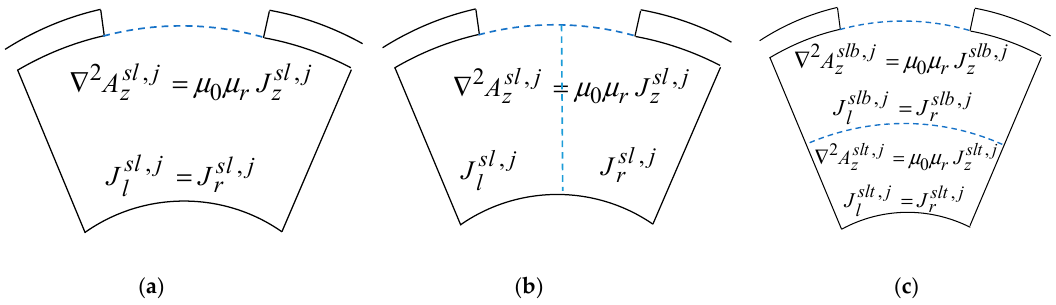
Figure 3. Sub-region division according to the winding configuration: ( a ) whole slot is considered as one region and belongs to one coil, ( b ) whole slot is considered as one region and left side and right side of the slot belongs to different coils, ( c ) whole slot divided into upper and lower sub-regions and each part belongs to one coil.